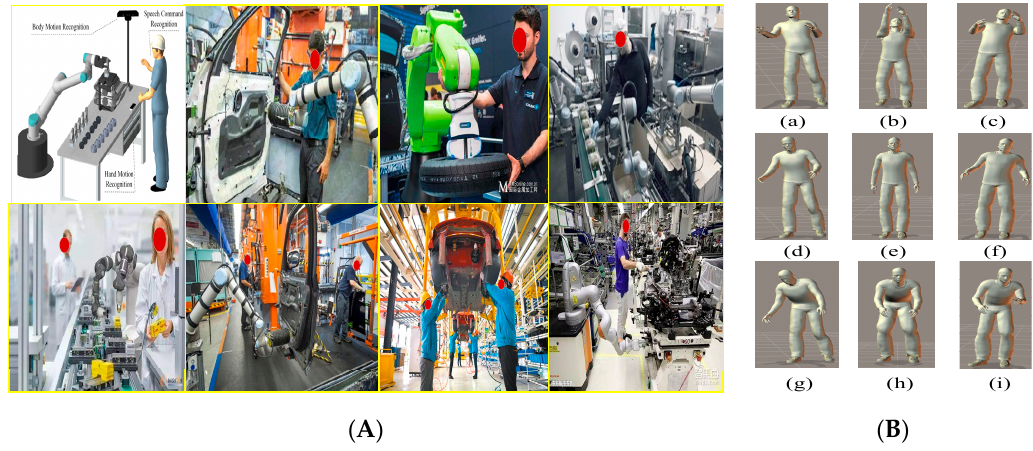
Figure 2. ( A ) Some actual scenes of human–robot cooperation. ( B ) Standing postures in the experiment: ( a ) right-backward standing (RBS); ( b ) back-incline standing (BIS); ( c ) left-backward standing (LBS); ( d ) right-leaning standing (RLS); ( e ) upright standing (URS); ( f ) left-leaning standing (LLS); ( g ) right-forward standing (RFS); ( h ) forward-leaning standing (FLS); ( i ) left-forward standing (LFS).